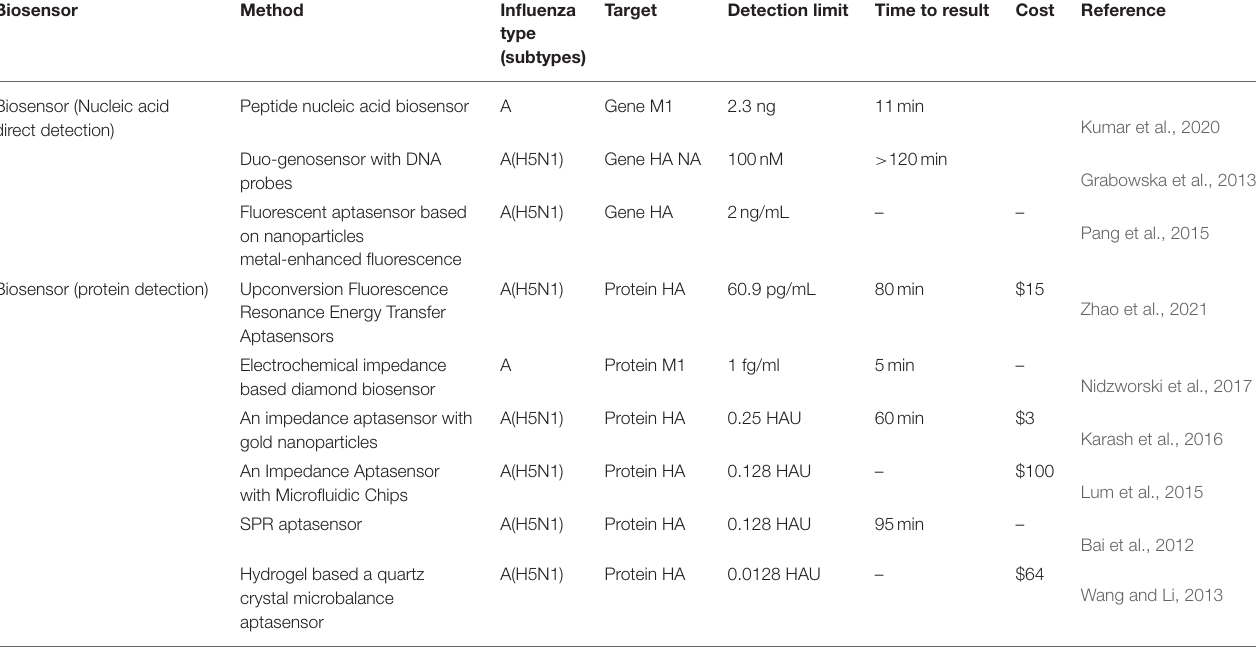
TABLE 3 | Comparison of biosensor detection of influenza